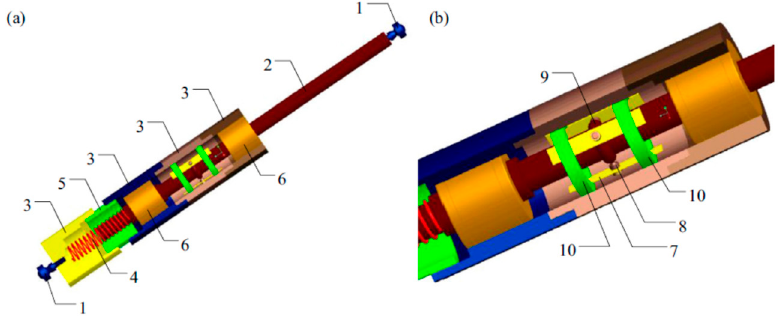
Figure 6. Schematic diagram of the quasi-zero stiffness (QZS) strut unit ( a ) Internal configuration; ( b ) a partially enlarged view [61].